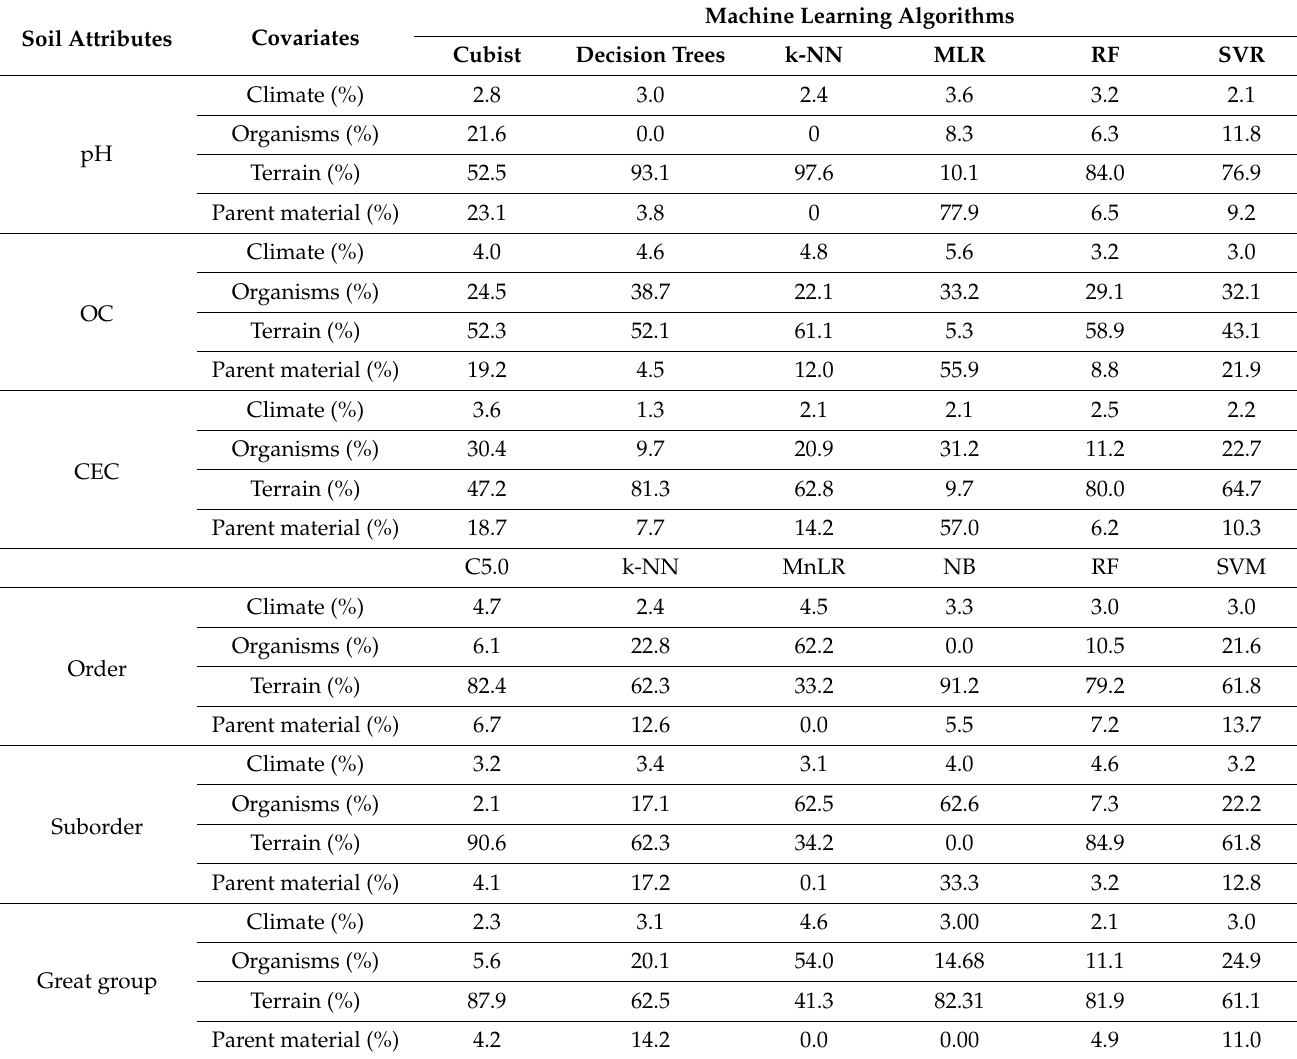
Table 6. Percentage contributions of the covariates to the soil attribute predictions implied through permutation feature